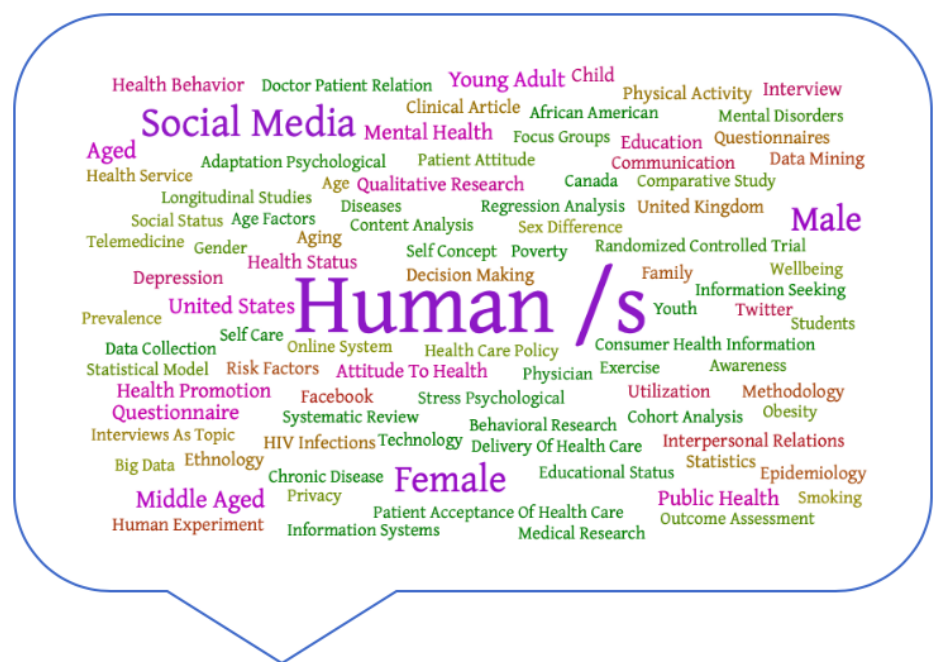
Figure 11. Cloud of the main keywords focused on social networks related to the health of young people.